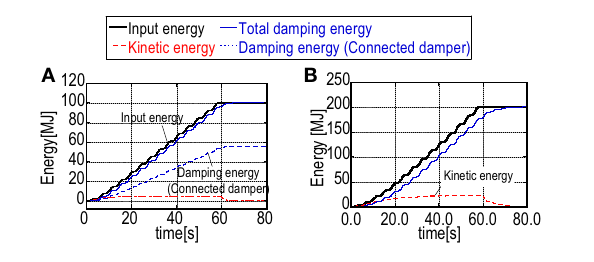
FIGURE 11 | Energy response of the proposed building model and other comparable model under the artificial long-period, long-duration earthquake ground motion (8.4s): (A) proposed building model and (B) multiple isolation building model (without connection)